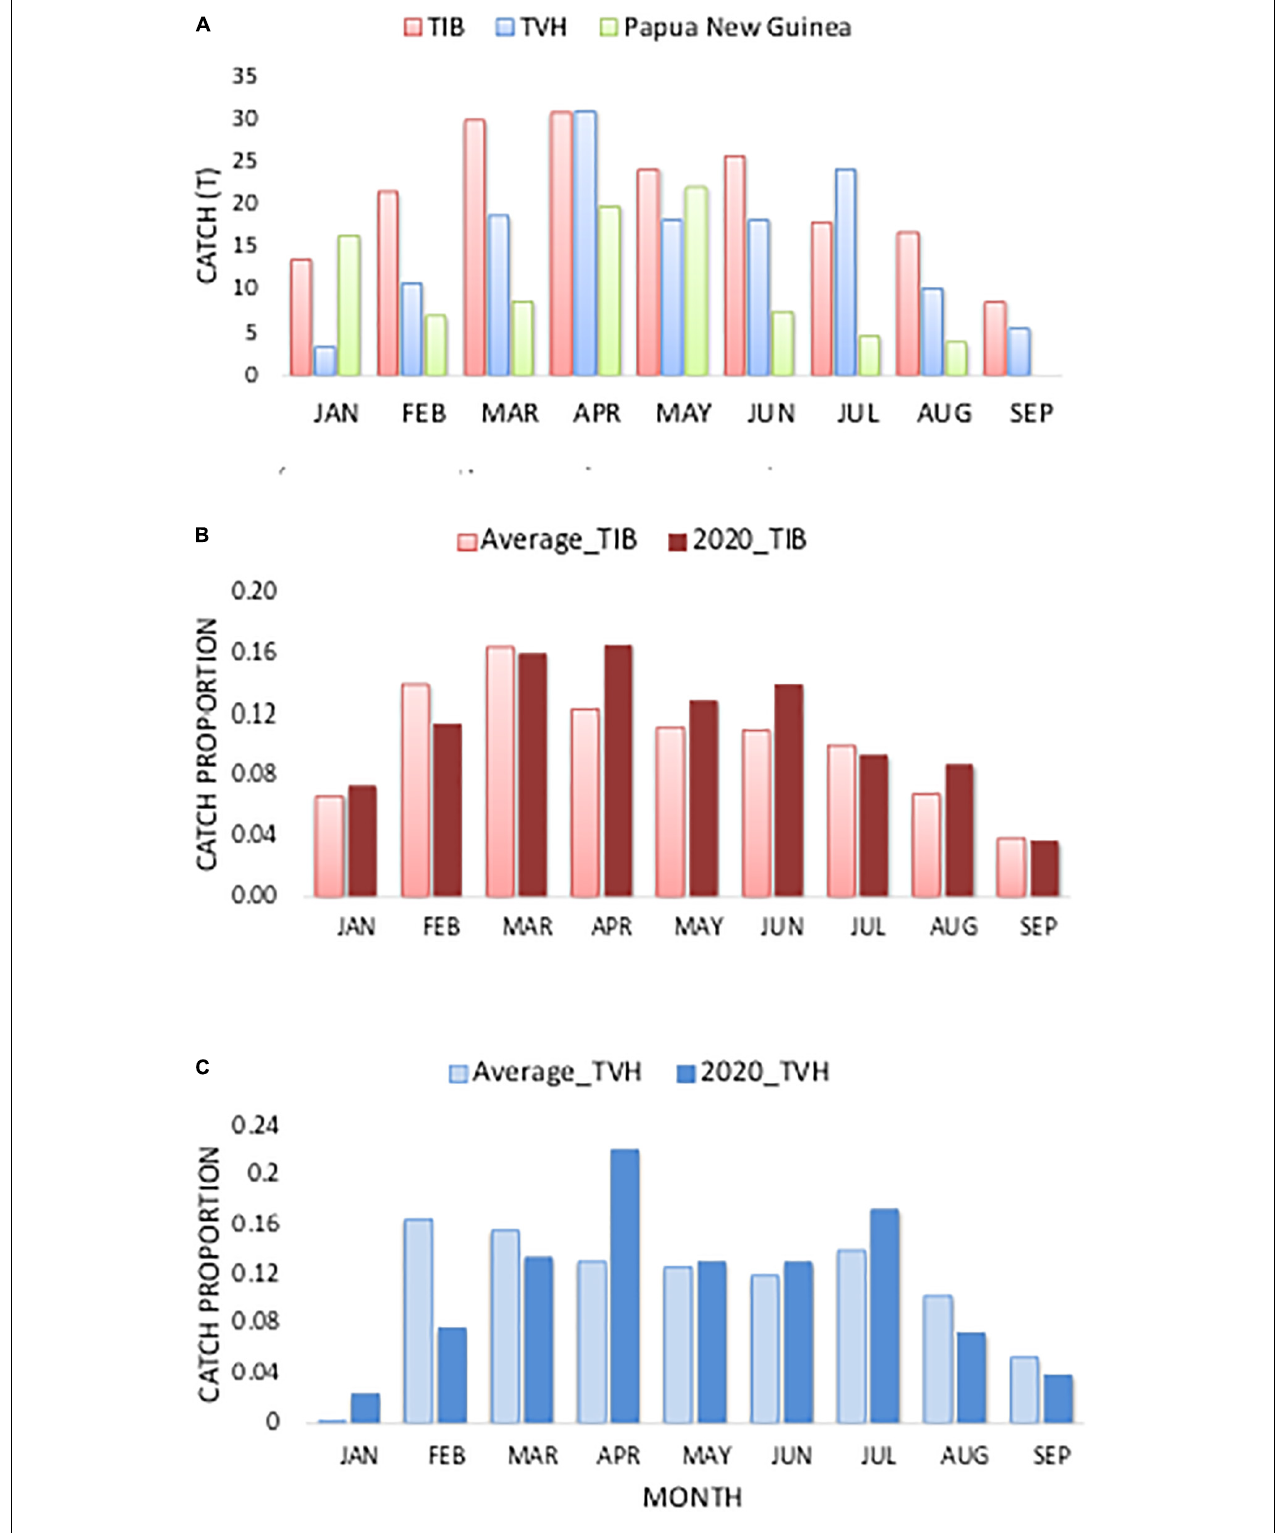
FIGURE 3 | Comparison of the relative proportion of fishing by (A) all sectors compared and (B) TIB sector and (C) TVH sector for months as indicated compared with the average pattern (average over 2004–2019). Data for Papua New Guinea (PNG) available until end of September only.